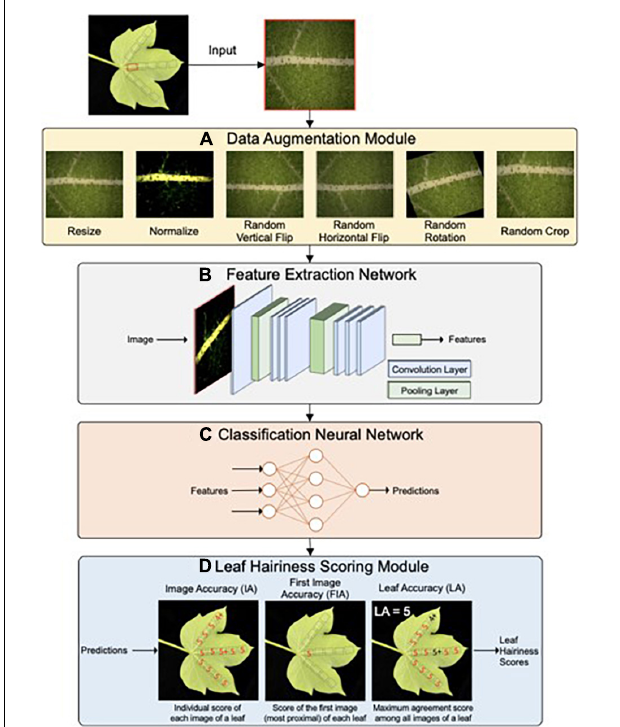
FIGURE 7 | Network architecture of the HairNet deep learning model to score cotton leaf hairiness. HairNet consists of four main parts. First a leaf surface images are passed through a Data Augmentation module (A) that augments each image by applying a variety of image processing techniques. Processed images are then passed to a Feature Extraction Network (B) that extracts discriminative visual features from the image representation. Extracted visual features are then passed to a simple Classification Neural Network (C) that assigns each input image to a specific leaf hairiness score. Raw scores are then processed by the Leaf Hairiness Scoring module (D) which generates three accuracy metrics for scoring cotton leaf hairiness. Adapted from Rolland et al. (2022) and is licensed under CC BY